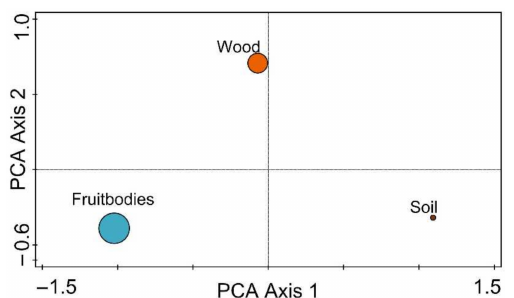
Figure 5. Ordination diagram based on principal component analysis of invertebrate communities from Heterobasidion spp. fruitbodies, Picea abies wood and soil samples. The size of each point reflects the relative richness of invertebrate